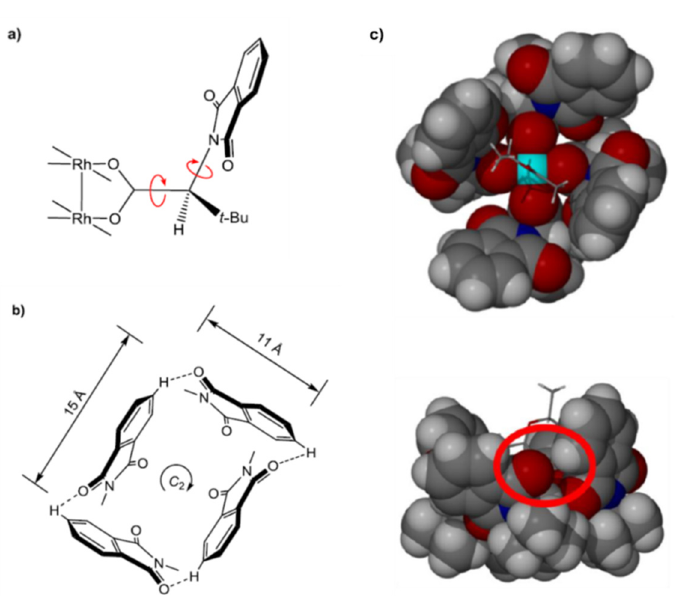
Figure 2. ( a ) Features that contribute to the chirality nature of the carbene binding cavity of Rh 2 ( S ‐